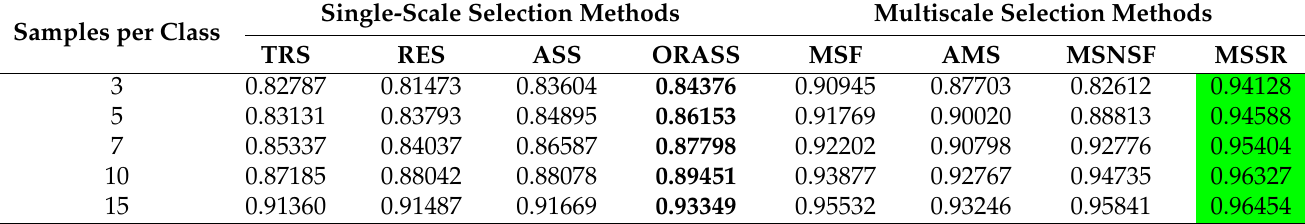
Table 11. OAs of different single scale and multi-scale fusion on university of Pavia dataset with different number of training samples per